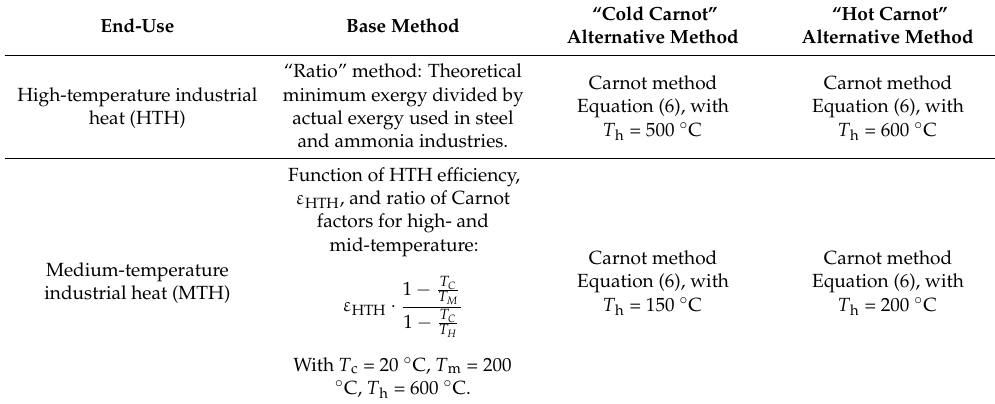
Table 3. Assumptions used under base and alternative methods for industrial heat.